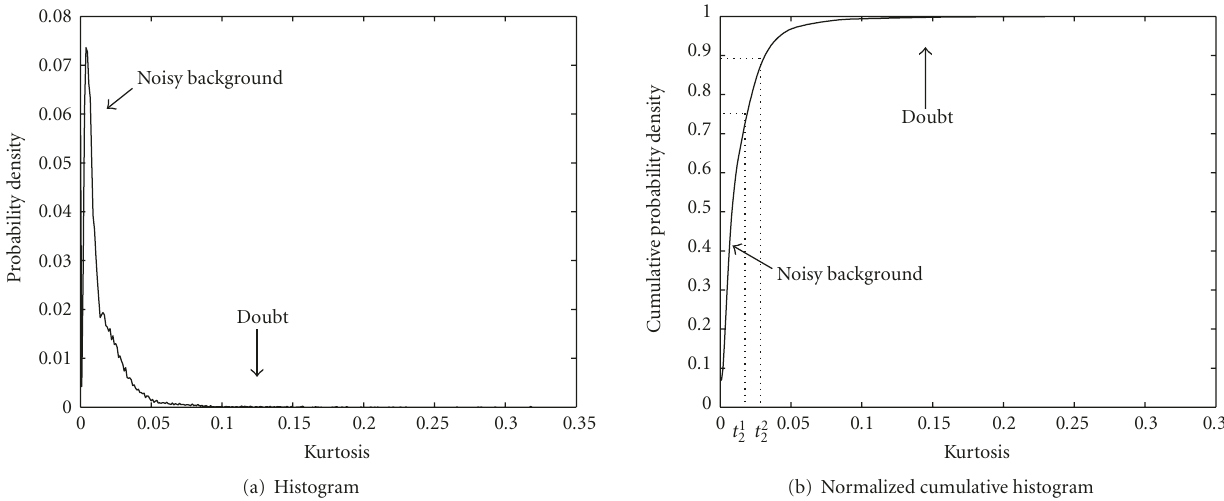
Figure 9: Example of histogram and cumulative histogram of a kurtosis image (after focusing and rebuilding, as presented on Figure